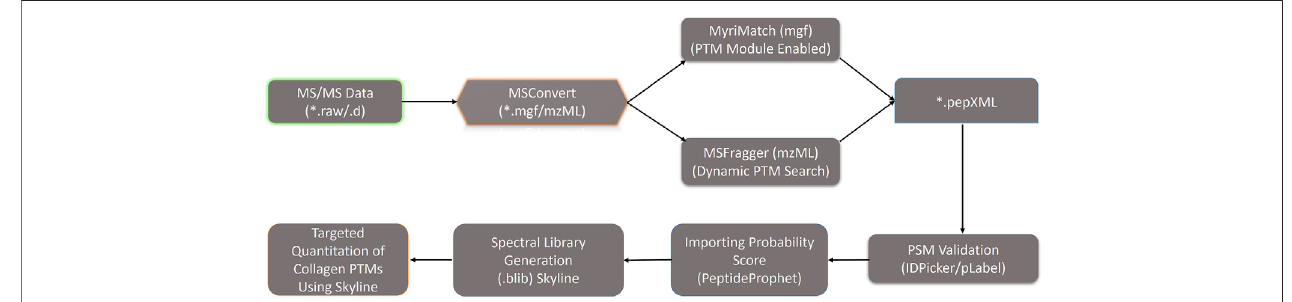
FIGURE 2 | Optimized dual database search engine-based MS analysis pipeline for the global identi fi cation and quantitation of site-speci fi c collagen PTMs from zebra fi sh heart ECM. Thermo. raw or Bruker. d MS/MS fi les were initially converted to. mgf and. mzML fi les (by MSConvert) respectively and searched with MyriMatch and MSFragger toidentifythecollagenpresent inthezebra fi shheart ECM.ForMyriMatch,thesubset ofidenti fi edproteins wasusedasaseconddatabase toperforma PTMmoduleenabledsearchde fi ningspeci fi csequencemotifsforthesite-speci fi cidenti fi cationofcollagenPTMsinzebra fi shheartECM.ForMSFragger,thePTM searches were conducted directly with the entire zebra fi sh database. From MyriMatch and MSFragger *.pep.XML output fi les containing each peptide spectrum match (PSM) were further parsed by PeptideProphet to compute the probability score (0,1). The *.pep.XML output fi le parsed by PeptideProphet was further imported into SkylinealongwithalltherawMS/MS fi les intogeneratethespectral library(.blib). Thisspectral library(.blib) inSkylinewasusedforthetargeted MS 1 -based extractionof all the PTM modi fi ed and unmodi fi ed collagen peptide species for each speci fi c site. The area of MS 1 area for each peptide for different samples was computed from